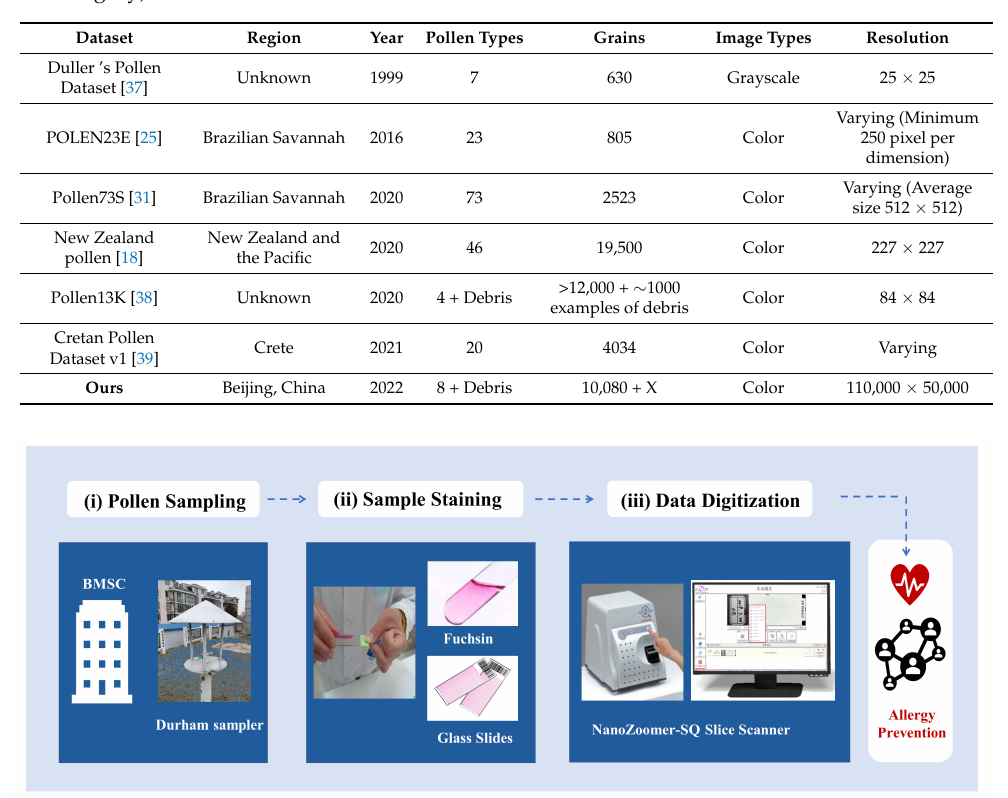
Figure 2. Specifically, the staffs regularly collect pollen samples from the Durham sampler